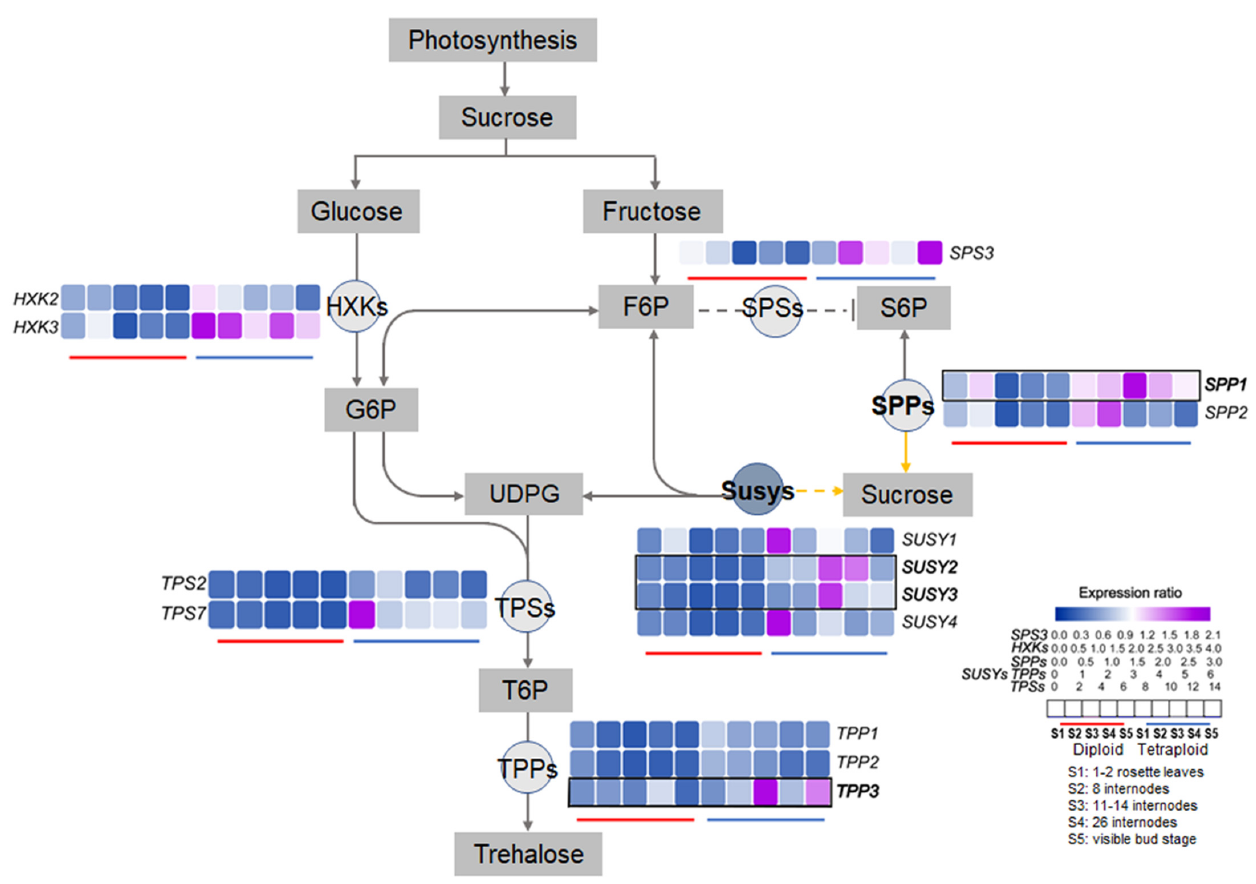
Figure 9. Putative sucrose metabolism − mediated regulatory network in lily hybrid allodiploids and their allotetraploid counterparts during development, with sorghum taken as a reference [22]. UDPG, uridine diphosphate glucose. G6P, glucose 6 − phosphate. F6P, fructose 6 − phosphate. The arrows of the dotted lines represent the potential regulatory relationships between two genes or metabolites. The grey and yellow connection lines with arrows represent sucrose cleavage and synthesis processes, respectively. The black − framed portion represents the expression levels of genes that displayed opposite expression patterns during lily development after polyploidization.